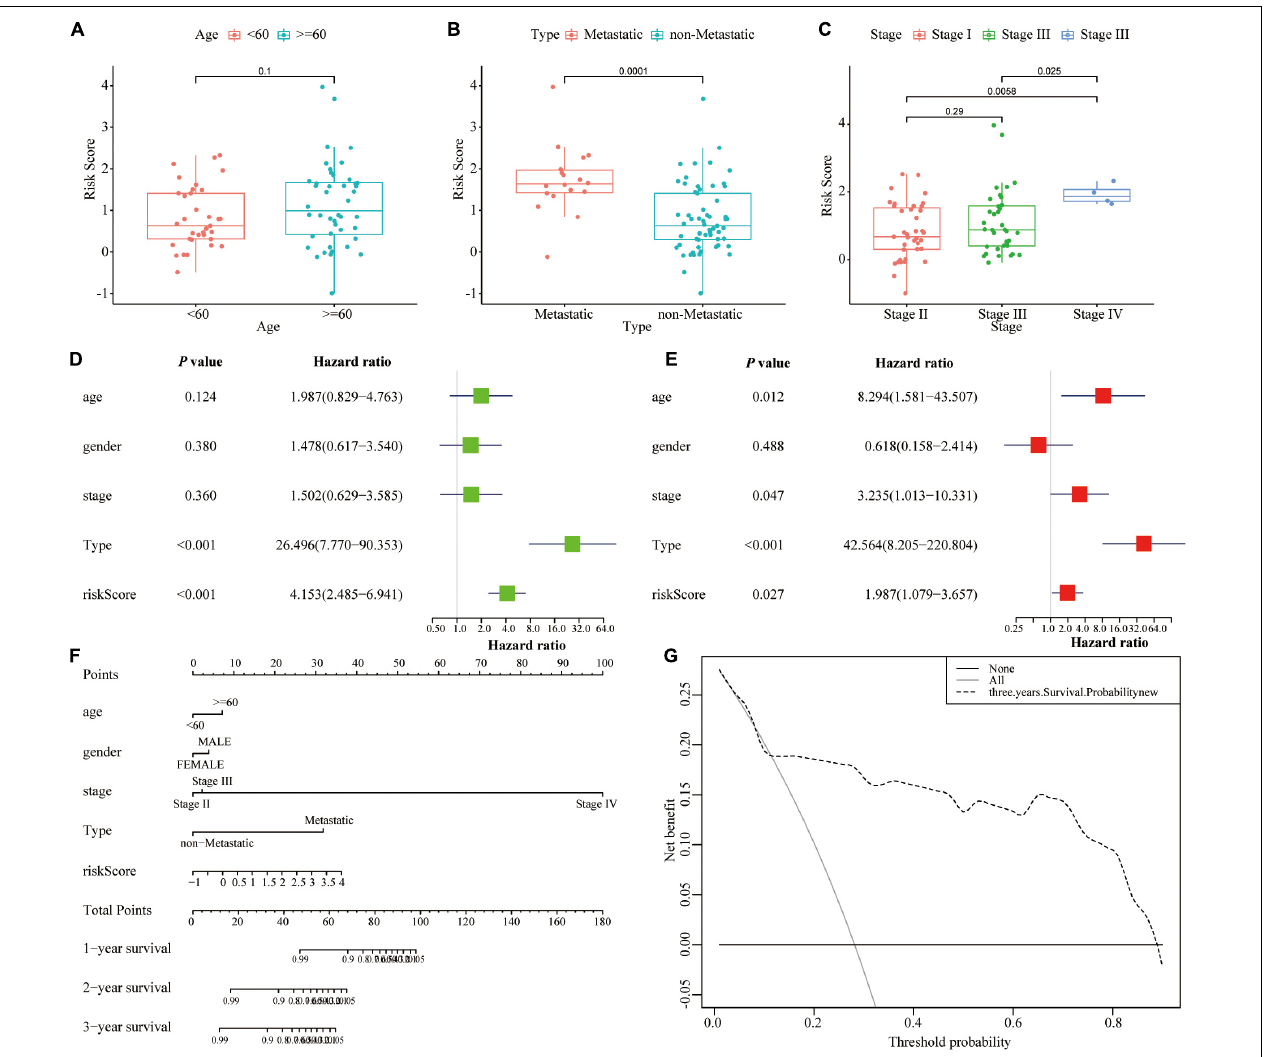
FIGURE 6 | Nomogram for predicting the overall survival probability of patients with UM. (A–C) The relationships between risk score of lncRNA signature and clinical parameters including age, metastasis, and stage. (D,E) Univariate and multivariate Cox regression analysis for risk score of lncRNA signature and other clinicopathological characteristics. (F) The nomogram was established based on lncRNA signature and other clinicopathological characteristics for predicting OS in UM patients at 1, 3, and 5 years. (G) DCA curves of the nomogram in UM patients at 3 years.